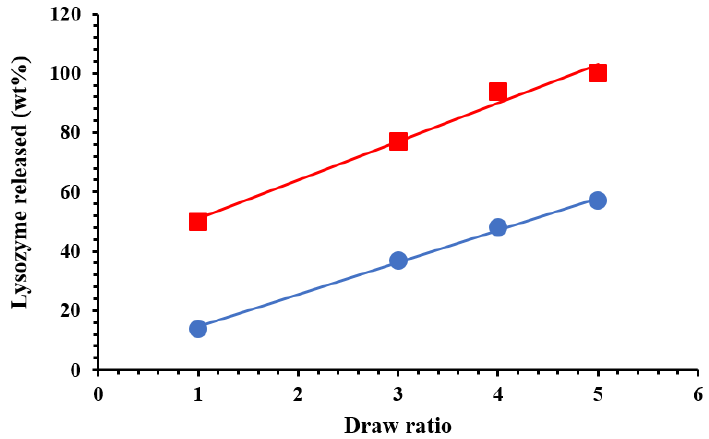
Figure 8. Lysozyme released (wt %) after: 24 h ( ● ) and one month ( ■ ).